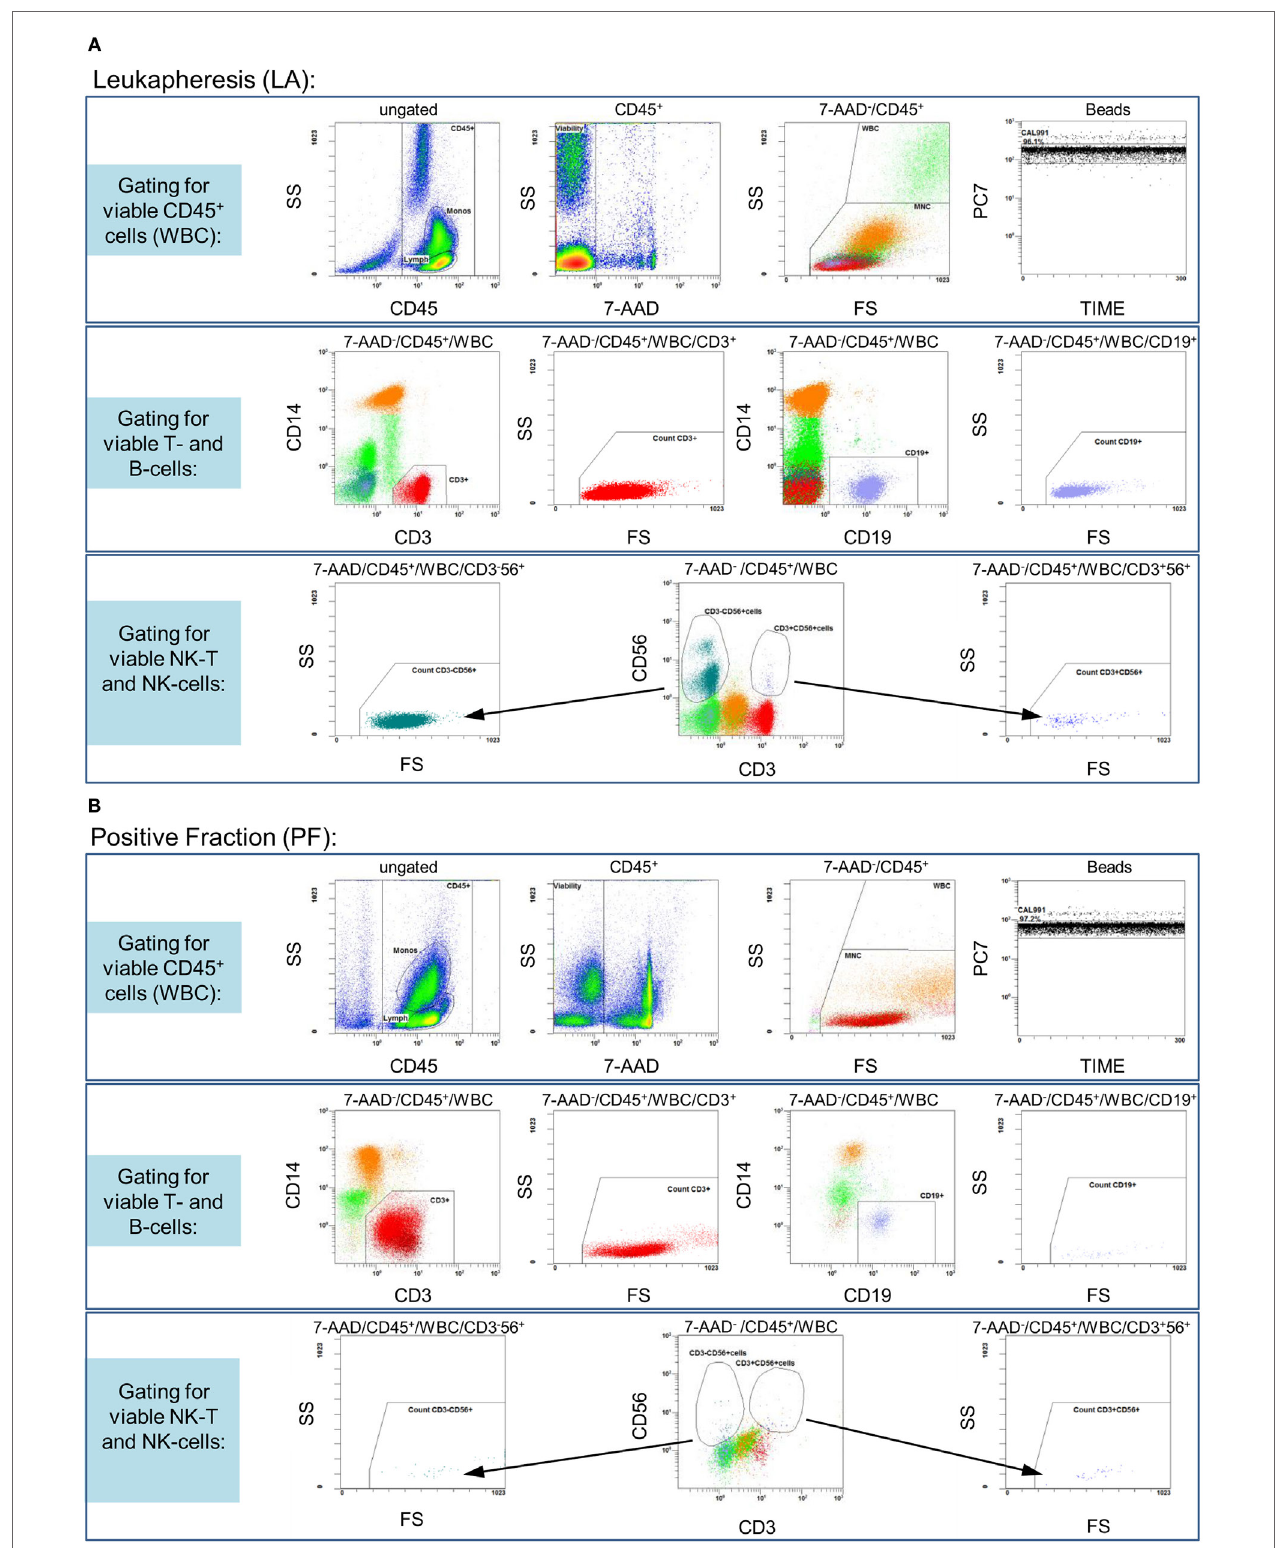
FIGURe 2 | Gating strategy: flow cytometric quality control for the quantification of IFN- γ + and IFN- γ − (Cd3 + /Cd4 + /Cd8 + ) t-cells